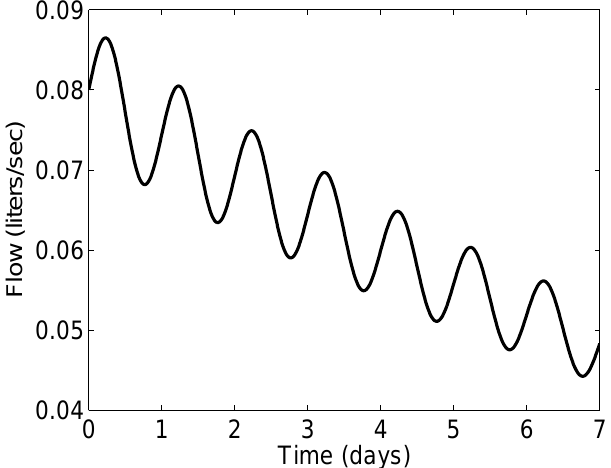
Figure 1. Sample subsurface pattern given by Equation (6) using A = 0.003 (1/h), B = 0.08 (L · s − 1 ), C = 0.008 (L · s − 1 ) and ν = 1 (h − 1 24